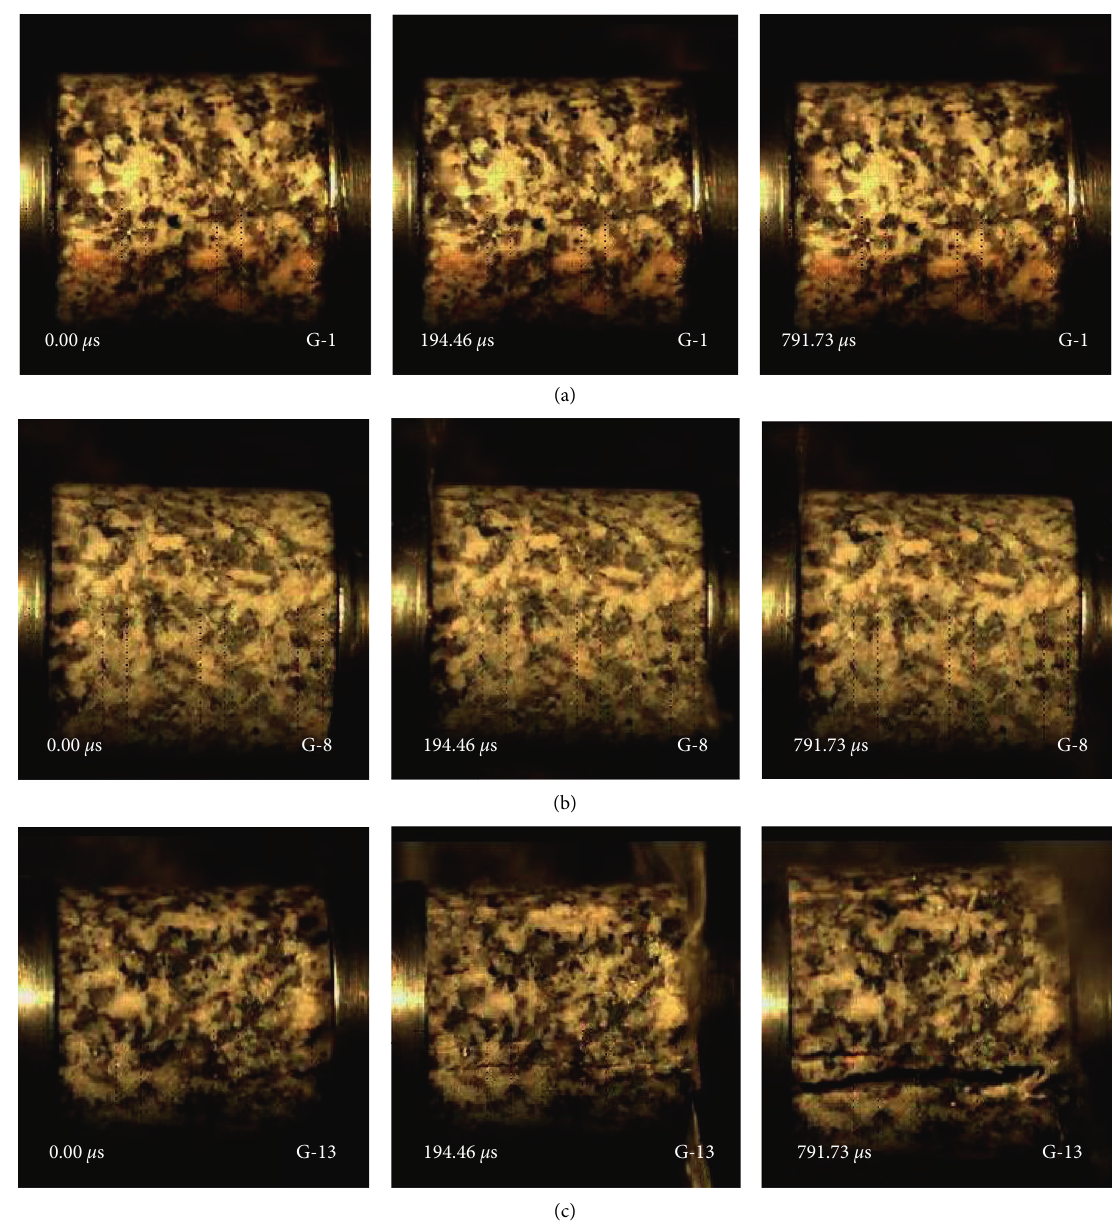
Figure 6: Failure processes of specimens in types I, II, and